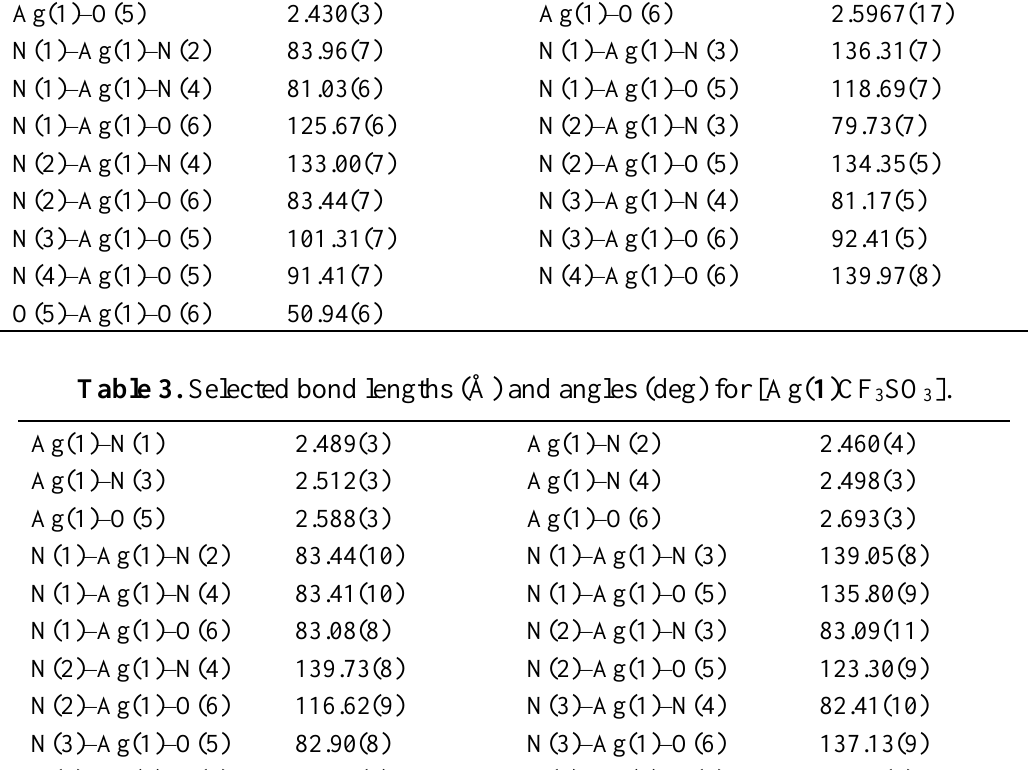
Table 2. Selected bond lengths (Å) and angles (deg) for [Ag( 1 )NO